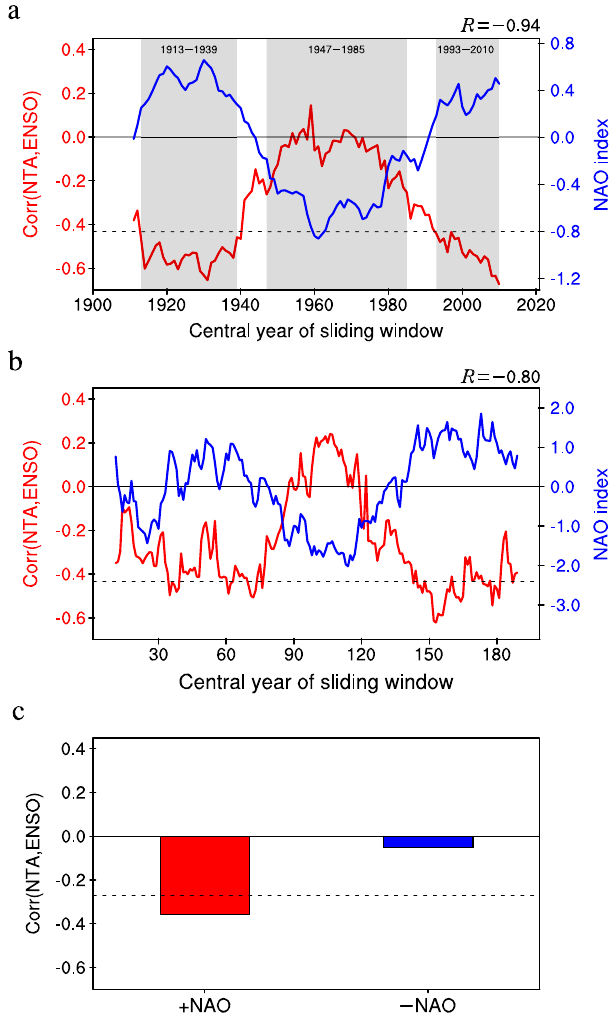
Fig. 1 | Relationship between the North Tropical Atlantic (NTA) − El Niño- Southern Oscillation (ENSO) connection and North Atlantic Oscillation (NAO) inobservationsandmodels.a The21-yearslidingcorrelationcoef fi cientsbetween the boreal spring (MAM0) NTA sea surface temperature (SST) index and sub- sequent boreal winter (D0JF1) Niño3.4 index (red line), and the 21-year running averages of the normalized NAO index during the previous boreal winter – spring seasons (D − 1JFMAM0) (blue line) for the period 1900 – 2021 in observations. The correlation coef fi cient between the NTA − ENSO connection and NAO is − 0.94 (signi fi cantatthe95%con fi dencelevel).Theimpactofthepreviouswinter(D − 1JF0) ENSO has been removed from the MAM0 NTA SST index using linear regression withrespecttotheNiño3.4index,andthedashedlineindicatesthe95%con fi dence level for the sliding correlation coef fi cients. Bands of gray shading indicate two high correlation periods (1913 – 1939 and 1993 – 2010) and a low correlation period (1947 – 1985) of the NTA − ENSO connection. b Same as ( a ), but for the NTA − ENSO connection and NAO derived from the 200-yr pre-industrial model simulation by the Community Earth System Model (CESM). The correlation coef fi cient between the modeled NTA − ENSO connection and NAO is − 0.80 (signi fi cant at the 95% con fi dencelevel). c The correlationcoef fi